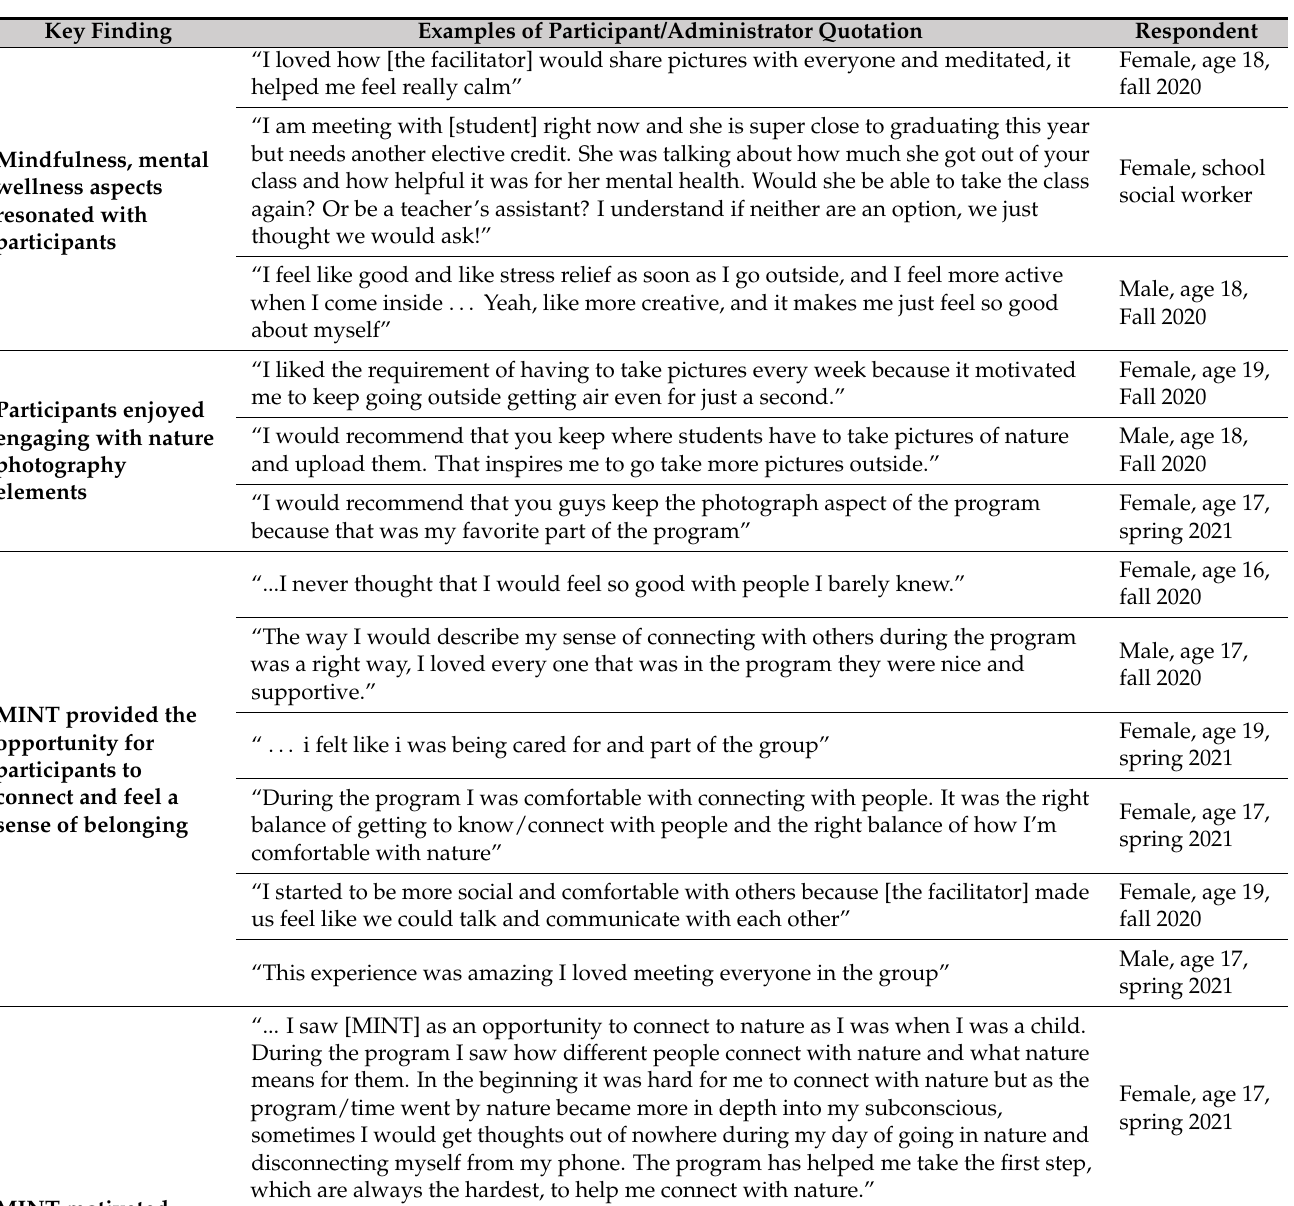
Table 5. MINT Participant and Administrator